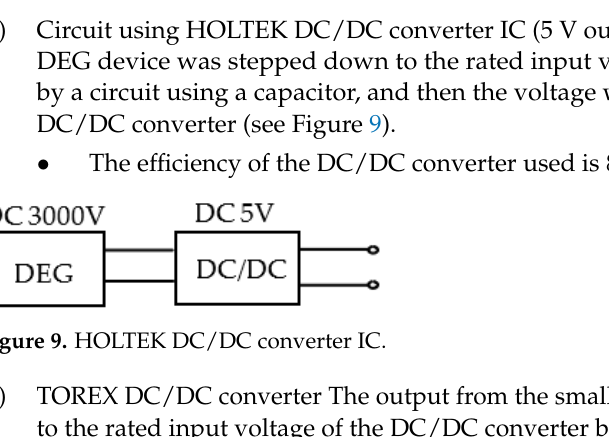
Figure 10. TOREX DC/DC converter. (5) Circuit using Zener diode (5 V output) The output from the small DEG device was stepped down to a few volts by a circuit using a capacitor, and then converted to a constant voltage using a Zener diode (see Figure 11). Figure 11. Circuit using Zener diode. (6) Shunt regulator circuit with TI reference voltage IC (5 V output) The output from the small DEG device was stepped down to a few volts in a circuit using capacitors. After that, a constant voltage was set using a shunt regulator circuit using a reference voltage IC (see Figure 12). •